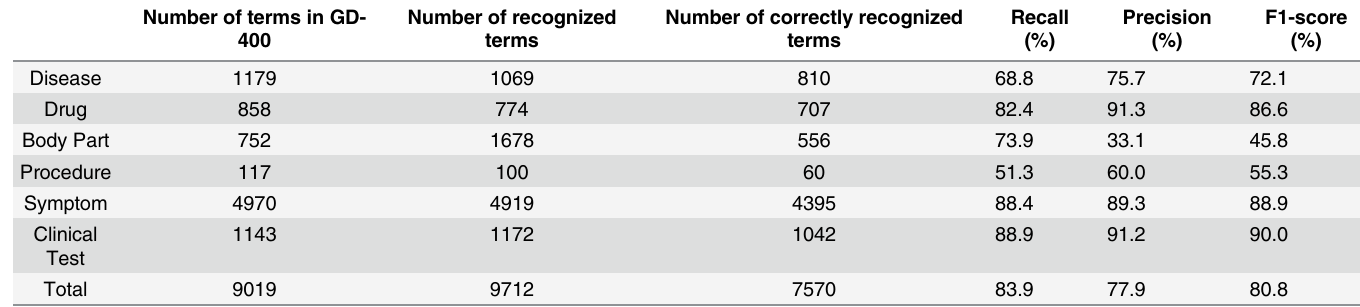
Table 1. Term recognition by the core